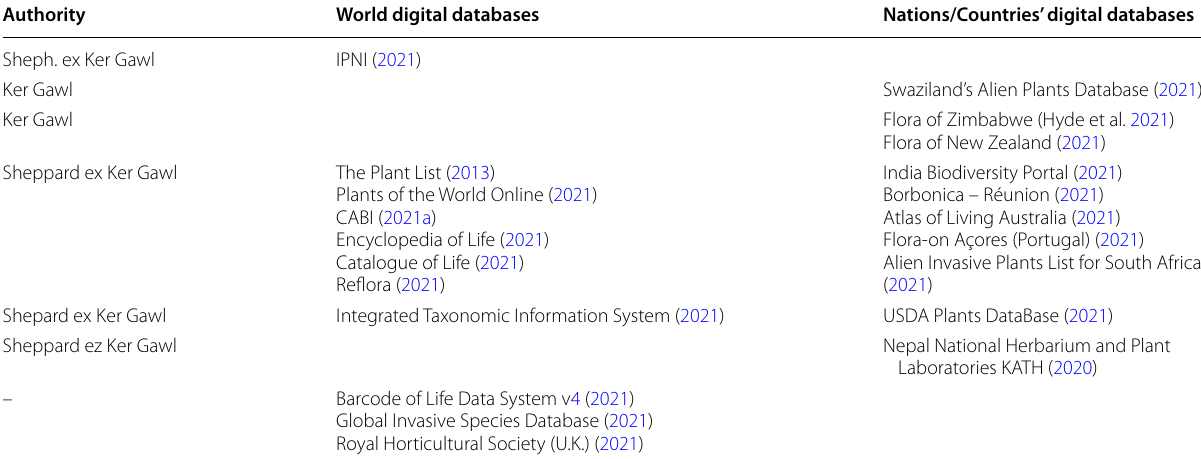
Table 1 Hedychium gardnerianum : authority variations, incorrect spelling of authority and absence of authority in digital databases of reference